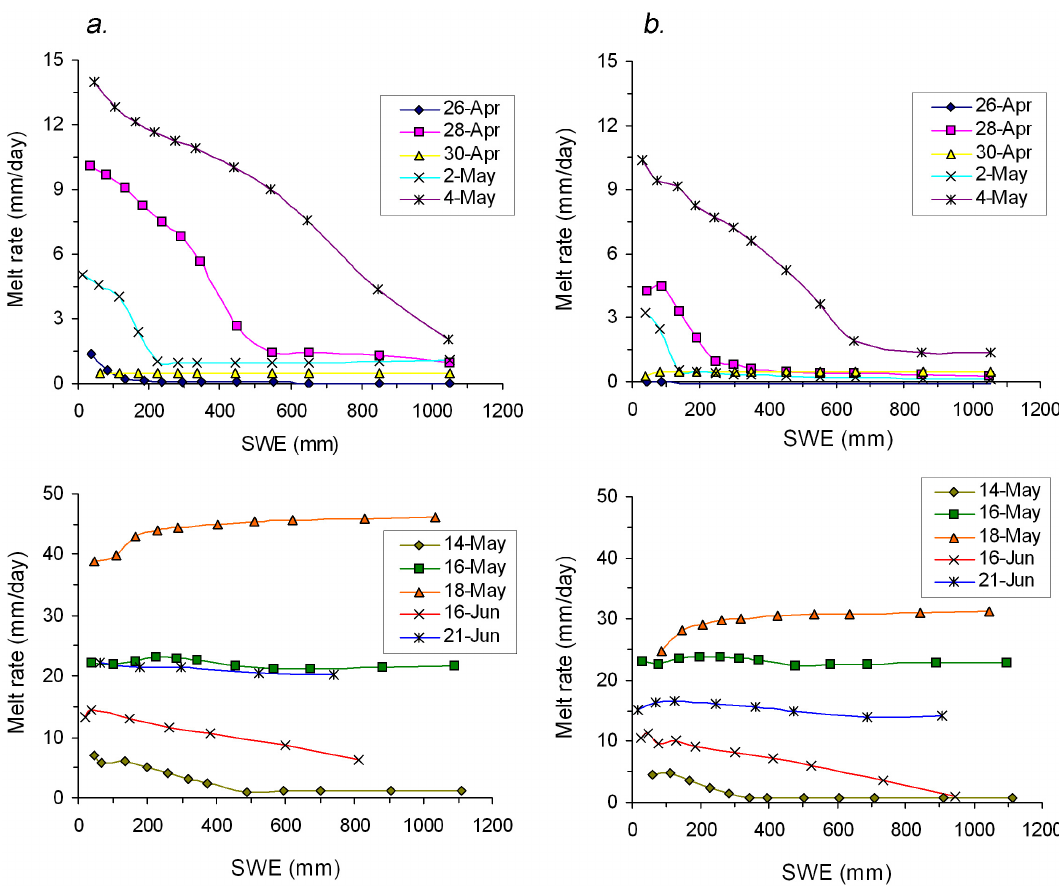
Fig. 4. Plots of simulated melt rates vs. SWE on consecutive dates at various times throughout the melt period in 2008 at (a) the south-east facing station and (b) the north facing station on Fisera